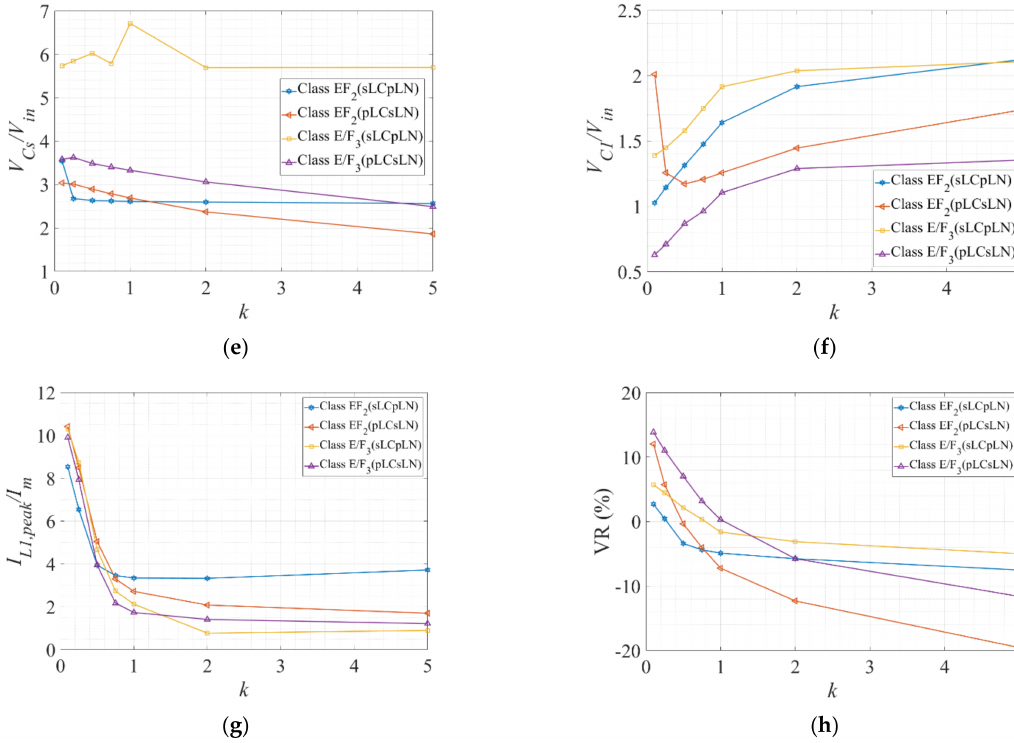
Figure 9. ( a ) The power output capability ( c p ); ( b ) efficiency ( η ); ( c ) the normalized peak switch voltage ( V S 1 ,peak / V in ); ( d ) the normalized peak switch current ( I S 1 ,peak / I m ); ( e ) the normalized peak resonant capacitor voltage ( V cs,peak / V in ); ( f ) the normalized peak auxiliary resonant capacitor voltage ( V C 1 ,peak / V in ); ( g ) the normalized peak auxiliary resonant current